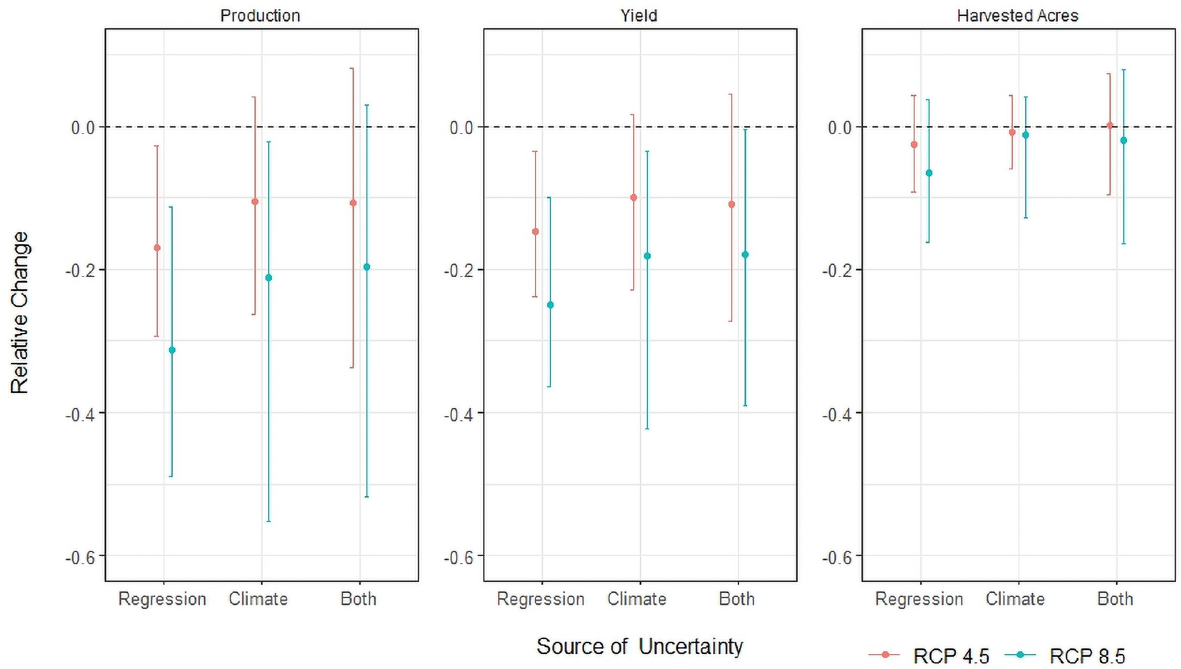
Fig 2. Decomposition of the relative change in production by yield and harvested acres by mid-century (2034–65) using ensemble average climate variables under RCP 4.5 and 8.5. The dot indicates the mean effect and whiskers show the 95% confidence interval. The left plot shows the total impact from yield and harvested acres, while the other two panels show the impact of yield and harvested acres. Regression uncertainty accounts for uncertainty in the statistical model, climate uncertainty accounts for uncertainty across 18 different climate models, and both combines the uncertainty from both